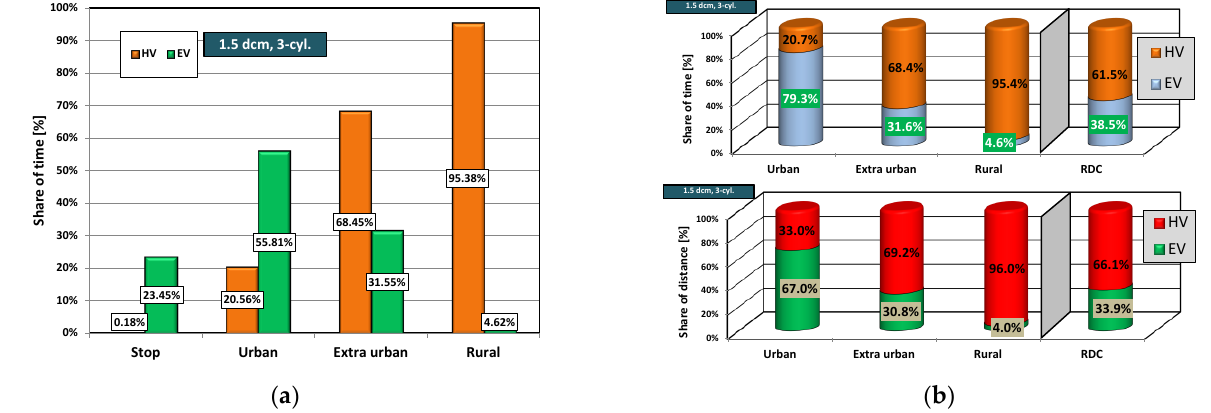
Figure 8. Operating conditions of the hybrid and electric powertrains in the new generation (3-cylinder engine): ( a ) the share of operation of the EV and the HV modes in individual portions of the test (vehicle stops included); ( b ) the share of the EV mode in relation to time and distance.